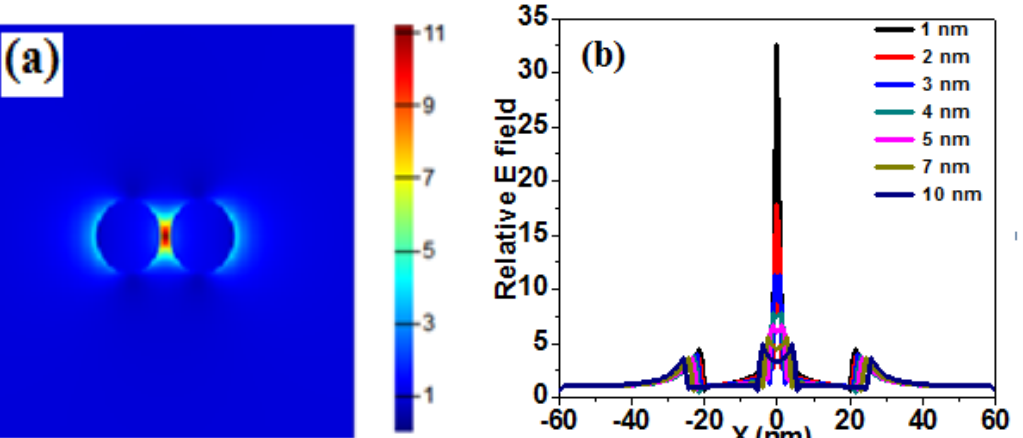
Figure 5: (a) The near-field pattern at a plasmon resonance wavelength in xz-plane for two identical Au nanospheres forming a homo-dimer nanostructure with particle size as 20 nm. The interparticle spacing is 3 nm. The image width is from - 60 nm to 60 nm. The plasmon resonance wavelength is 522 nm.(b) Interparticle spacing dependent  along x- axis for Au homo-dimer